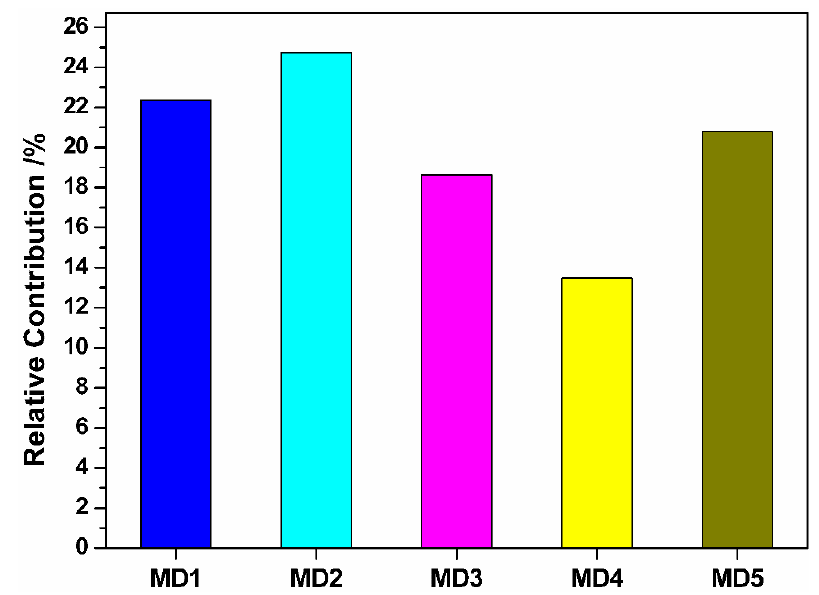
Figure 4. Contributions of the five molecular descriptors.